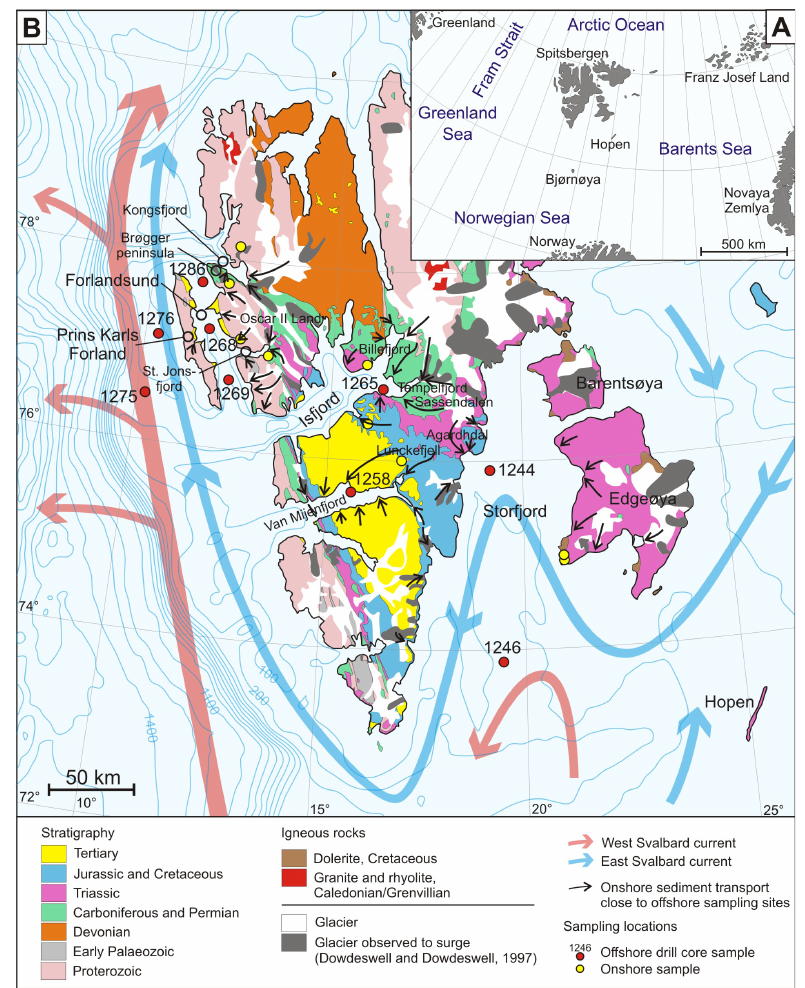
Fig. 1. (A) Location of Spitsbergen between the Greenland Sea, Barents Sea, Norwegian Sea and Arctic Ocean. (B) Simplified geological map of Spitsbergen according to Dallmann et al. (2002) with locations of offshore drill core samples (red dots) and onshore rock samples (yellow dots) and onshore sediment transport close to offshore sample locations (small black arrows). In addition, the map shows the East and West Spitsbergen currents and the distribution of surging glaciers according to Dowdeswell and Dowdeswell